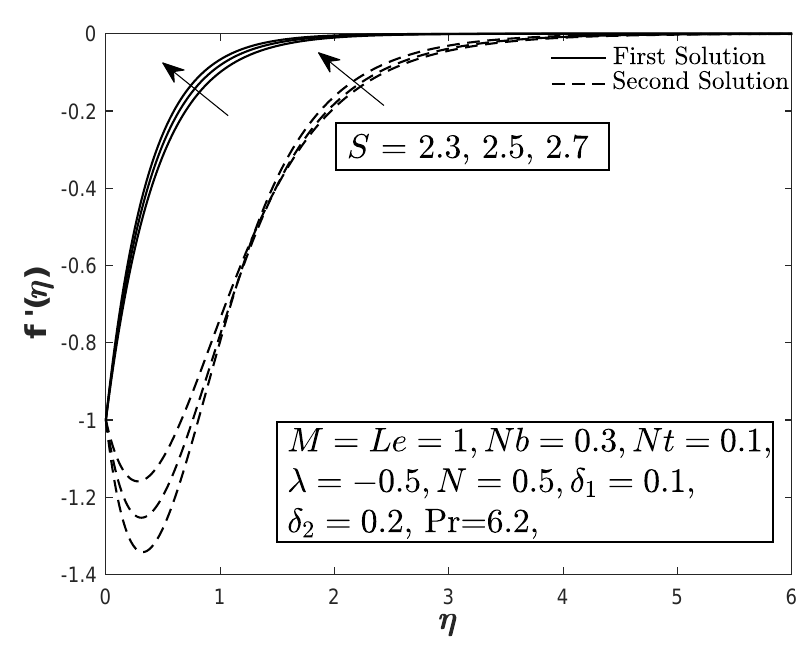
Figure 5. Effect of suction S on the velocity